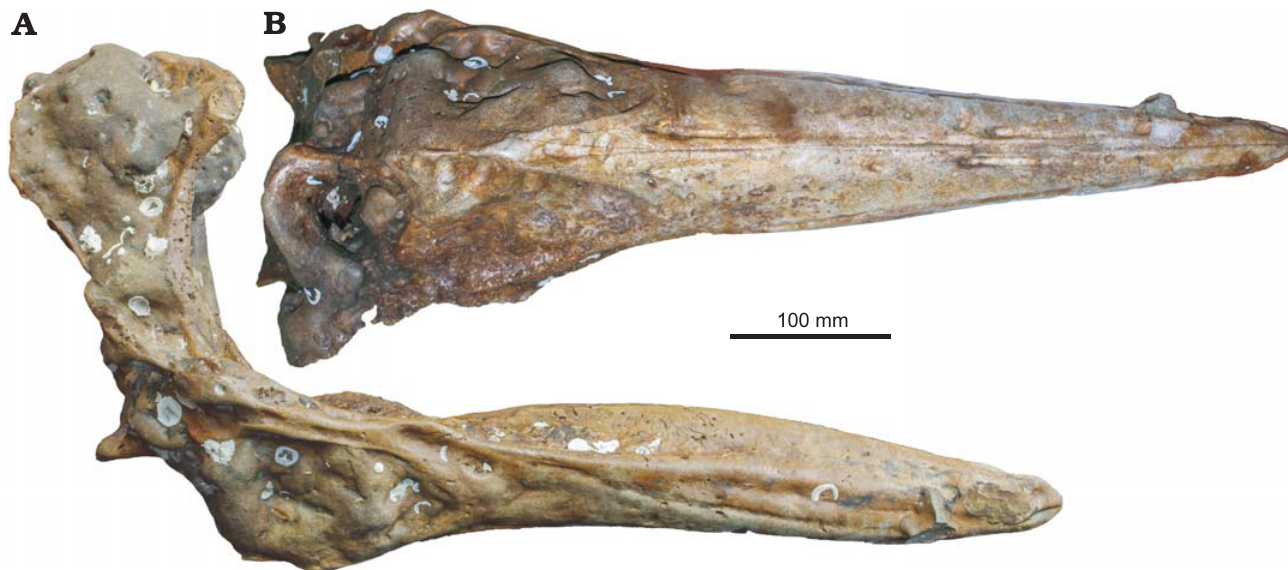
Fig. 2. Partial cranium of a beaked whale Beneziphius cetariensis sp. nov., holotype (SGHNMF MA0953) from the middle Miocene to early Pliocene of A Selva fishing ground, off the Galician coast, Spain, in right lateral ( A ) and ventral ( B ) views.